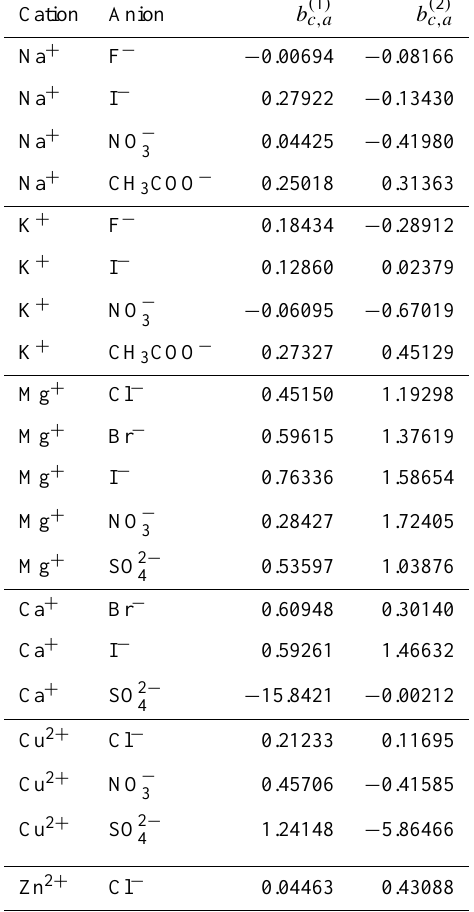
Table A2. Mod. LIFAC binary cation–anion MR interaction